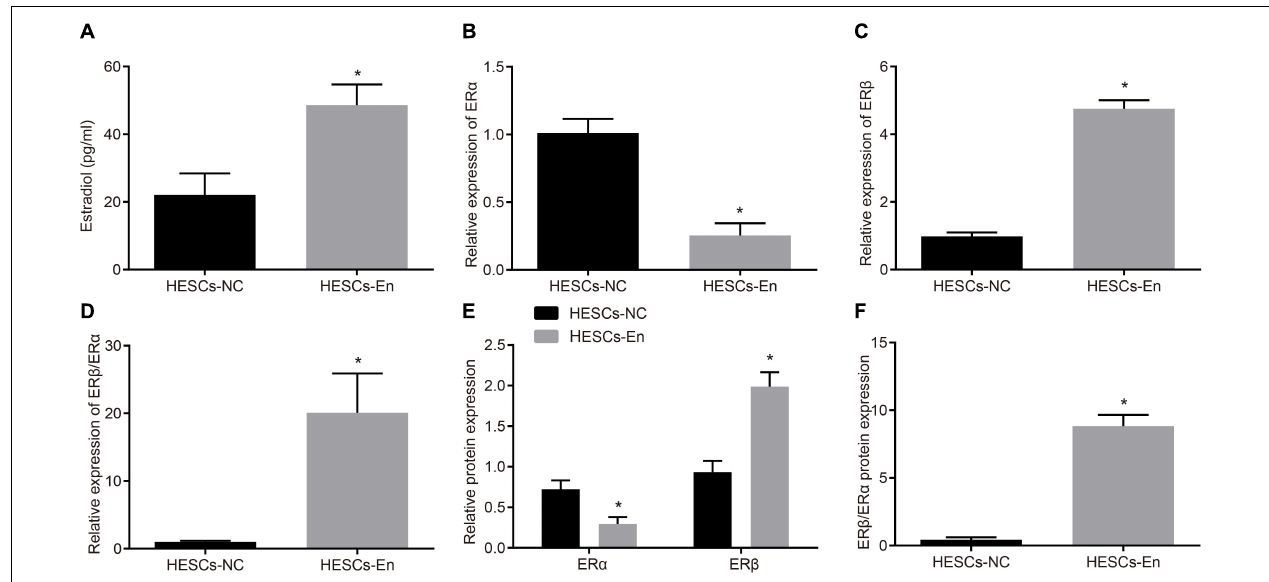
FIGURE 2 | ER α was down-regulated and ER β was up-regulated in endometriosis-related HESCs in vitro . (A) The expression of estradiol in HESCs-NC and HESCs-En determined by ELISA. (B) The mRNA expression of ER α in HESCs-NC and HESCs-En determined by RT-qPCR. (C) The mRNA expression of ER β in HESCs-NC and HESCs-En determined by RT-qPCR. (D) The relative expression of ER β /ER α in HESCs-NC and HESCs-En determined by RT-qPCR. (E) The protein expression of ER α and ER β in HESCs-NC and HESCs-En determined by Western blot analysis. (F) The protein expression of ER β /ER α in HESCs-NC and HESCs-En determined by Western blot analysis. Comparisons between two groups were analyzed using independent sample t -test. * p < 0.05 vs. the HESCs-NC cells. Cell experiments were conducted in